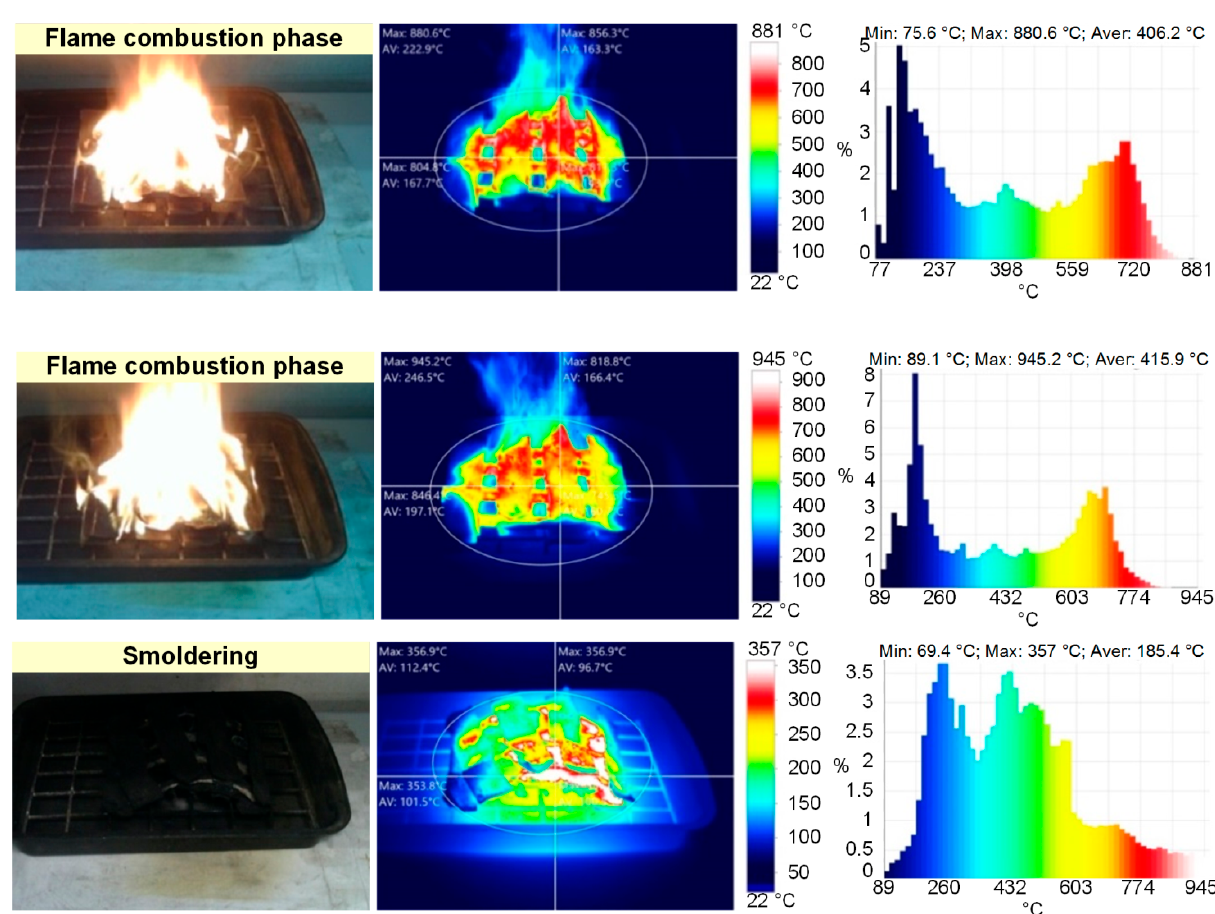
Figure 3. Thermal images of model fire (wood) combustion (flame combustion phase; transition from flame combustion to smoldering; smoldering).